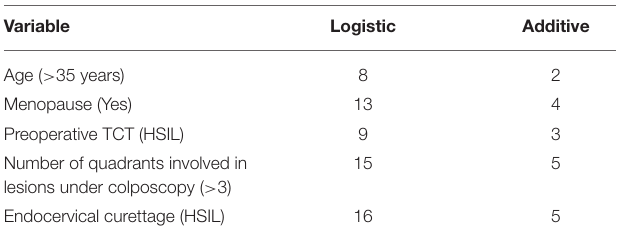
TABLE 3 | Scoring systems.